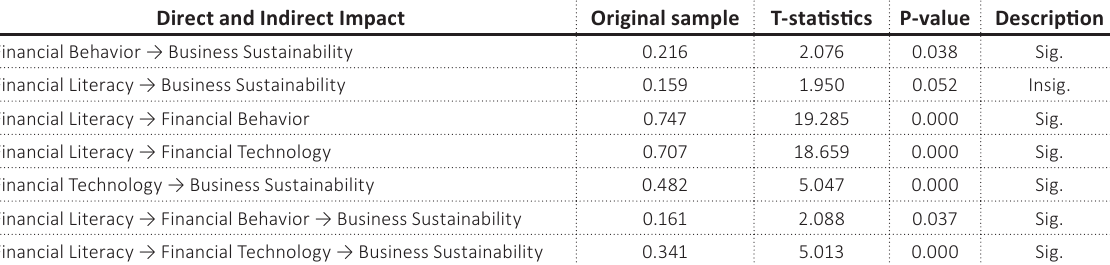
Source: Own elaboration using